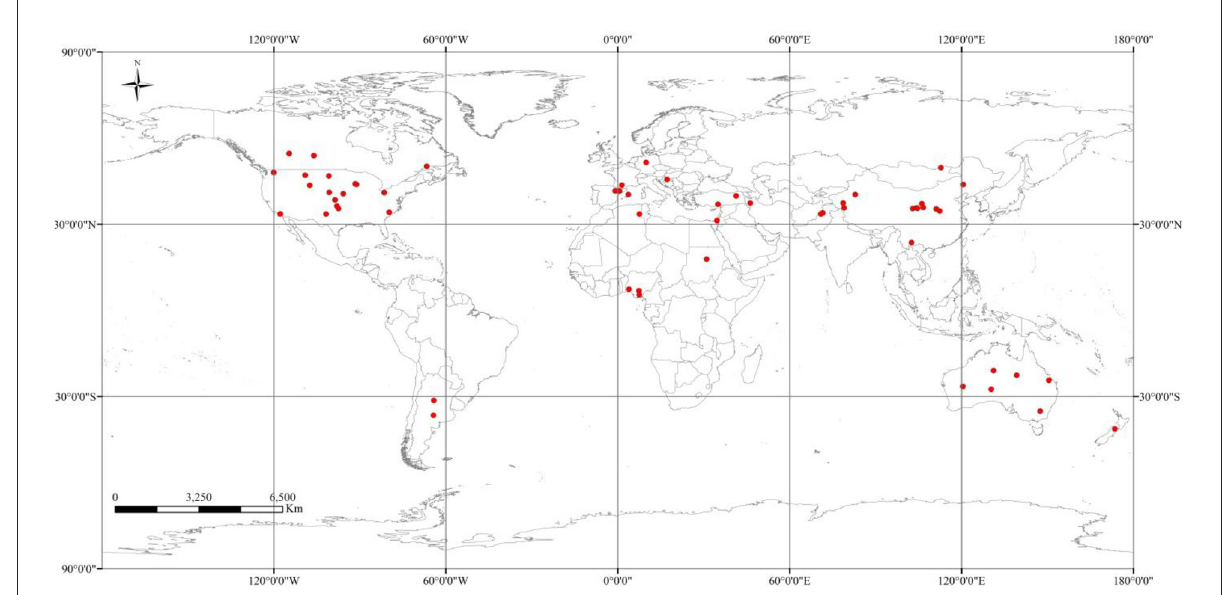
FIGURE1 Distribution of 97 experimental sites around the globe from where the data was collected for the